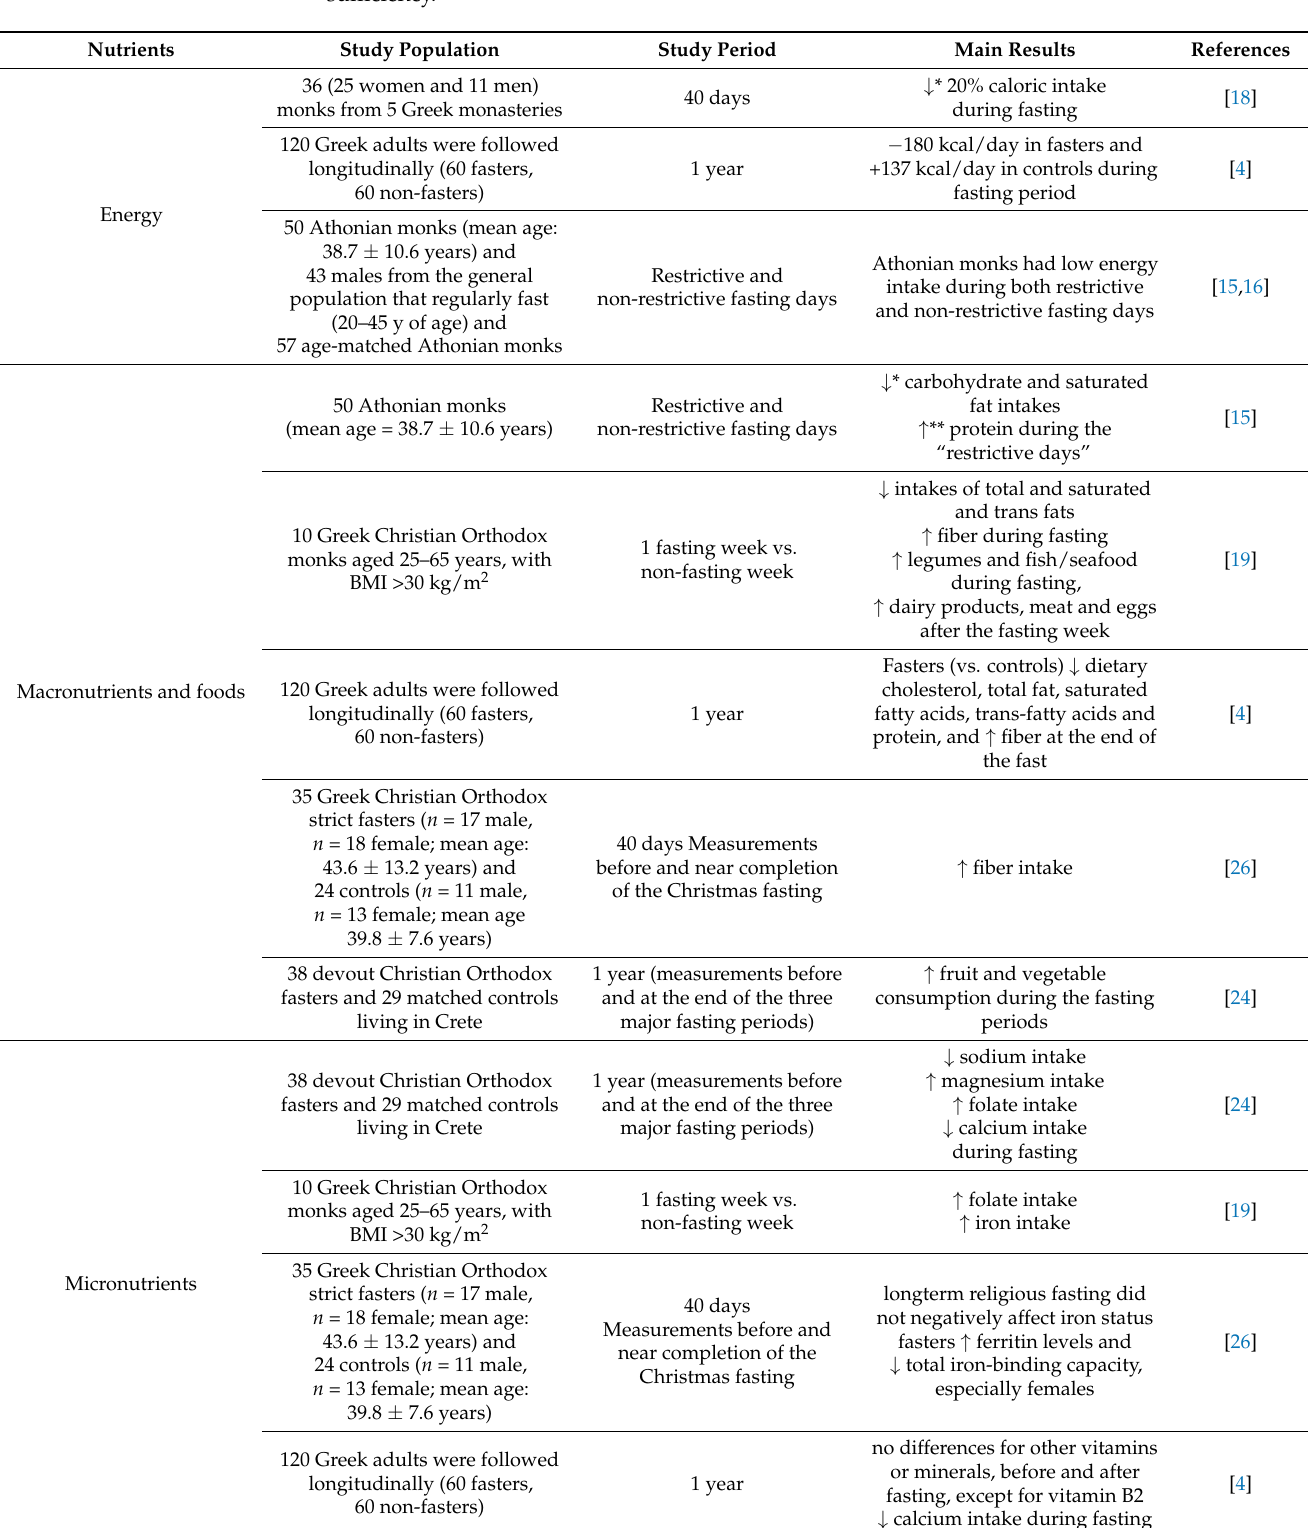
Table 3. Studies concerning the impact of Christian Orthodox fasting on nutrient intakes and